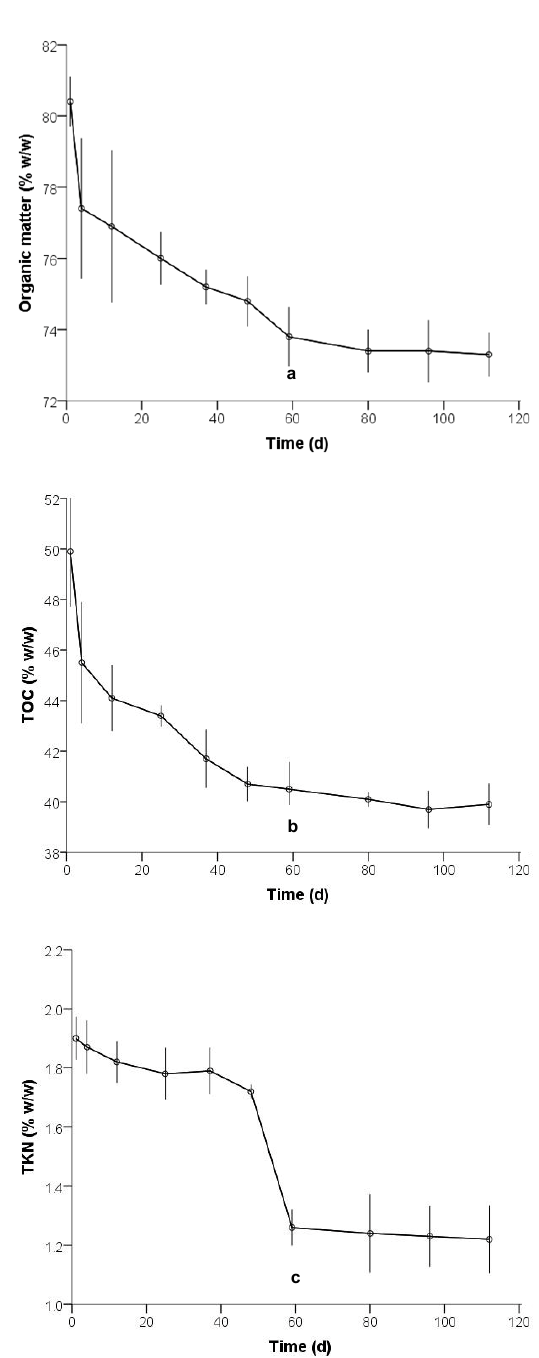
Figure 4. Variation in ( a ) the organic matter, ( b ) TOC, and ( c ) TKN values of the compost with time. Error bars were placed at the 95% confidence level.